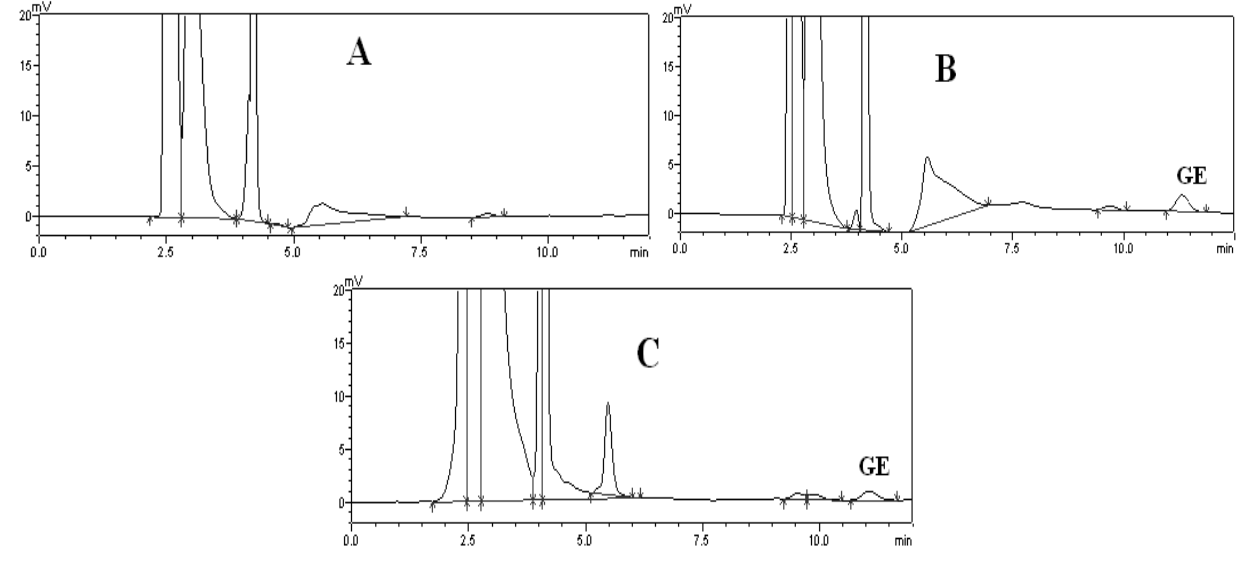
Figure 4. Non-compartmental analysis of pharmacokinetic data was performed by Kinetica 4.4 software. The pharmacokinetic parameters are shown in Table 1. The absolute bioavailability was F , F = AUC /AUC × 100%. The results showed that the average value of C blood (i.n./i.g.) blood (i.v.)